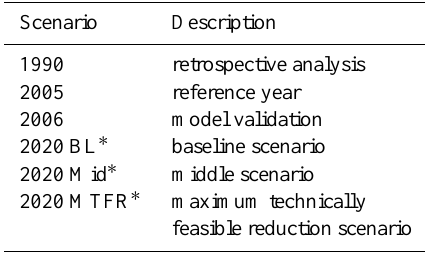
Table 1. Description of emission